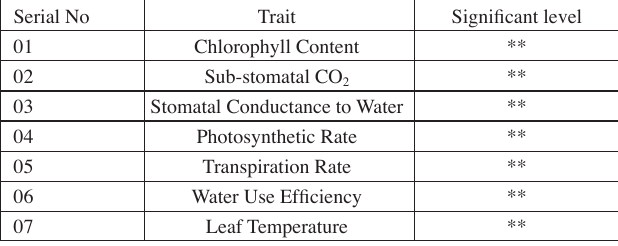
Tab. 4: Analysis of variance for individual trait (Physiological traits)